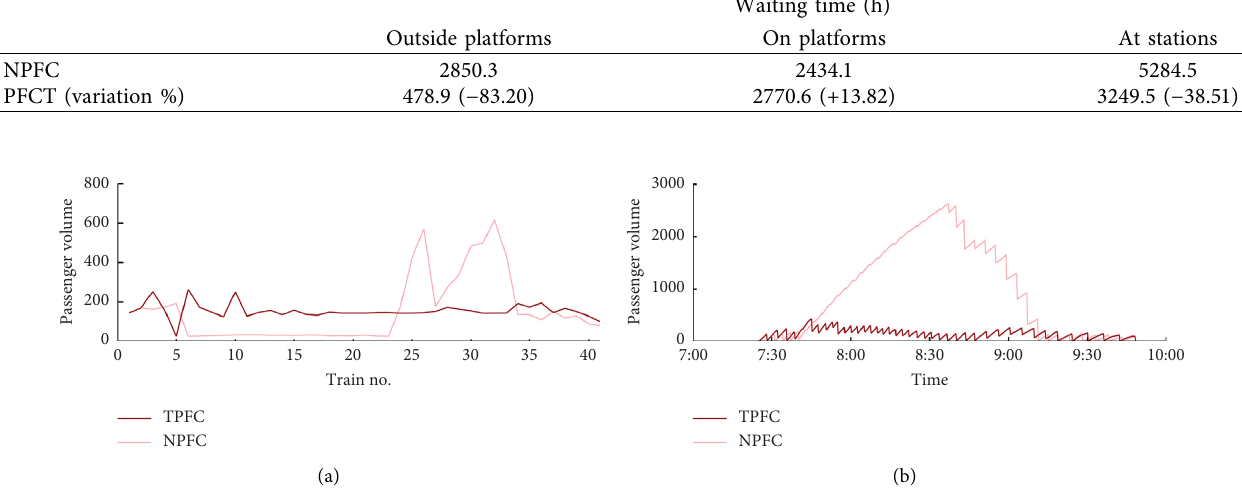
Figure 13: Passenger loading dynamics at CMDX Station: (a) boarding passengers; (b) accumulated